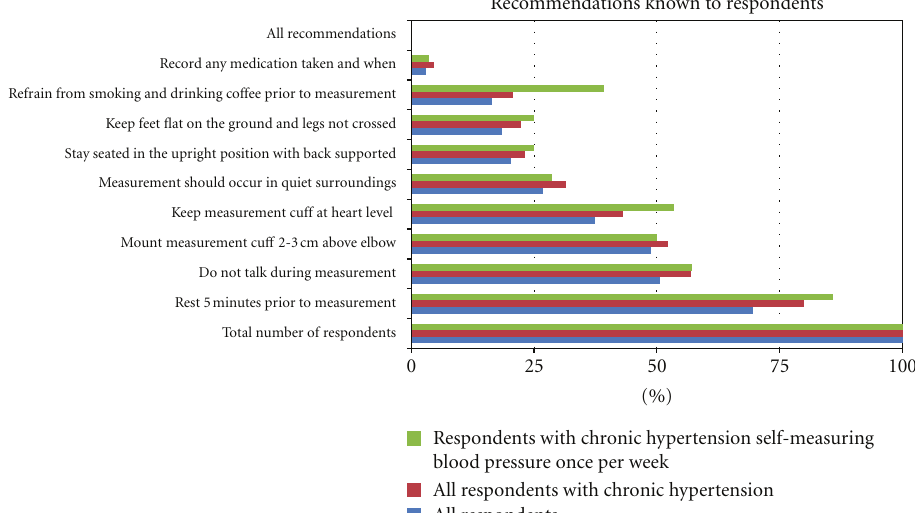
Figure 1: Illustrates the percentage of respondent understanding and knowledge of the recommendations when performing self- measurement of blood pressure. A total of 201 respondents provided answers as indicated in the subgroup color-coded blue. Of these, some 130 respondents self-reported to su ff er from chronic hypertension as indicated in the second subgroup (red). In the third subgroup (green) a total of 28 respondents self-reported to be su ff ering from chronic hypertension as well as self-measuring their blood pressure once per week. The percentage-figures are relative to each of the three